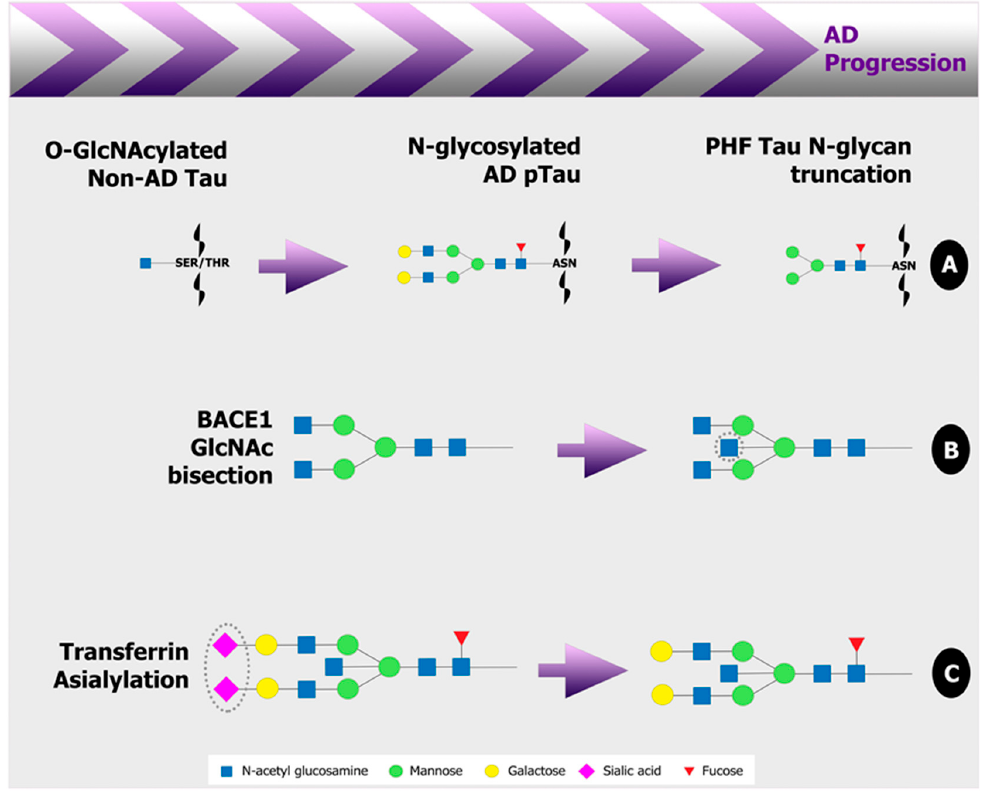
Figure 2. Examples of glycan alterations in disease related glycoproteins in Alzheimer’s disease (AD). ( A ) Tau, a central protein in the AD pathology, is O-GlcNAcylated which acts as a defense against hyperphosphorylation. In AD, O-glycosylation is downregulated and tau becomes uncharacteristically N-glycosylated. Both normal and hyperphosphorylated tau contain N-glycans in AD. Truncated glycans are more abundant on paired helical filaments (PHF) which are present later in the disease pathology. ( B ) Bisecting GlcNAc on β -secretase β -site APP-cleaving enzyme 1 (BACE1) occurs prior to toxic A β formation in AD. In contrast, GlcNAc bisection on amyloid precursor protein (APP) stimulates α -secretase production and acts as a protective mechanism against amyloid beta (A β ) peptide formation (not shown). ( C ) Decreased terminal sialic acids are present on AD cerebrospinal fluid (CSF) glycoproteins, the major glycoprotein being transferrin which is critical to the survival of neuronal cells. Additionally, BACE1 and presenilin, a subunit of γ -secretase, both have a direct role in the sialylation of AD relevant proteins. Grey dotted lines indicate location of changes on glycan structures. Alzheimer’s disease, AD; N-acetyl glucosamine, GlcNAc; amyloid beta, A β ; amyloid precursor protein, APP; cerebrospinal fluid, CSF; β -site APP-cleaving enzyme 1, BACE1; SER, serine; THR, threonine; ASN, asparagine; pTau, hyperphosphorylated tau; PHF, paired helical filaments. Images were created using Adobe Photoshop.